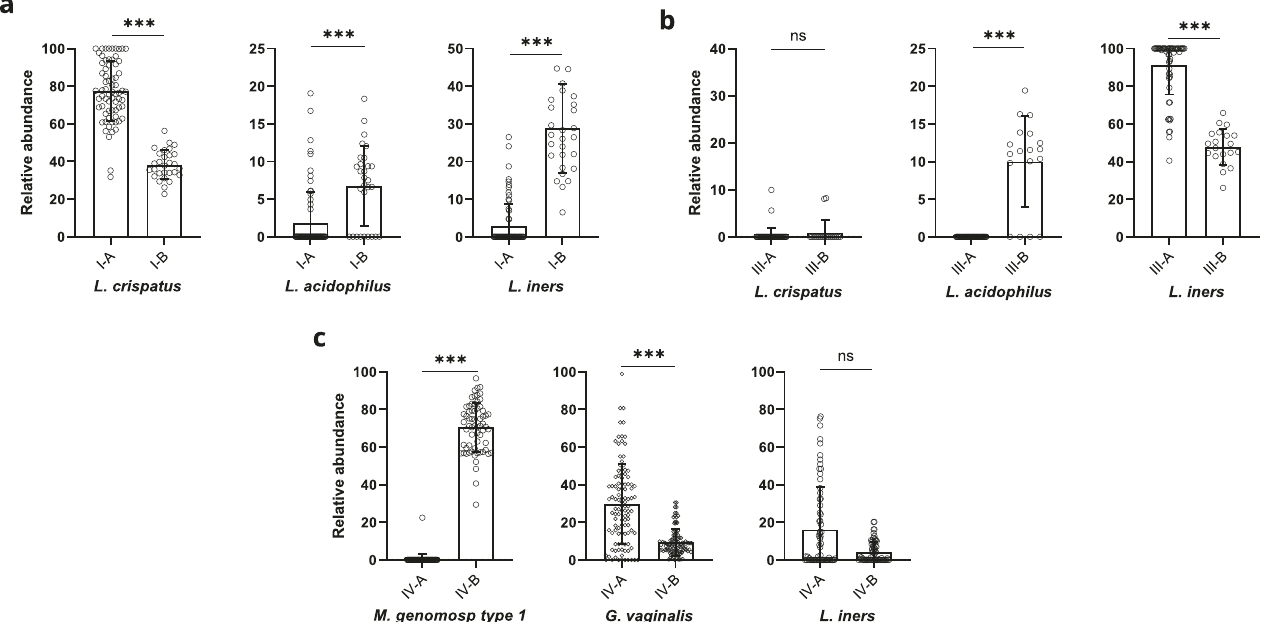
Fig. 3 Association of microbial relative abundances with CSTs. a Analysis of species relative abundances in CST I-A and I-B reveals a higher signi fi cant abundance for L. crispatus in I-A compared to I-B and for L. iners and L. acidophilus in I-B compared to I-A. b Analysis of CSTs III-A and III-B shows a signi fi cantly higher abundance for L. iners in III-A compared to III-B and for L. acidophilus in III-B compared to III-A. c Analysis of CSTs IV-A and IV-B demonstrates a signi fi cantly higher abundance for M. genomosp type 1 in IV-B than IV-A and for G. vaginalis in IV-A than IV-B. Error bars represent means ± s.d. and differences in relative abundances were analyzed by using a Mann – Whitney U test followed by Bonferroni correction. * p < 0.005; ** p < 0.001; *** p < 0.0001; ns, not signi fi cant. Source data are provided as a Source data fi le.